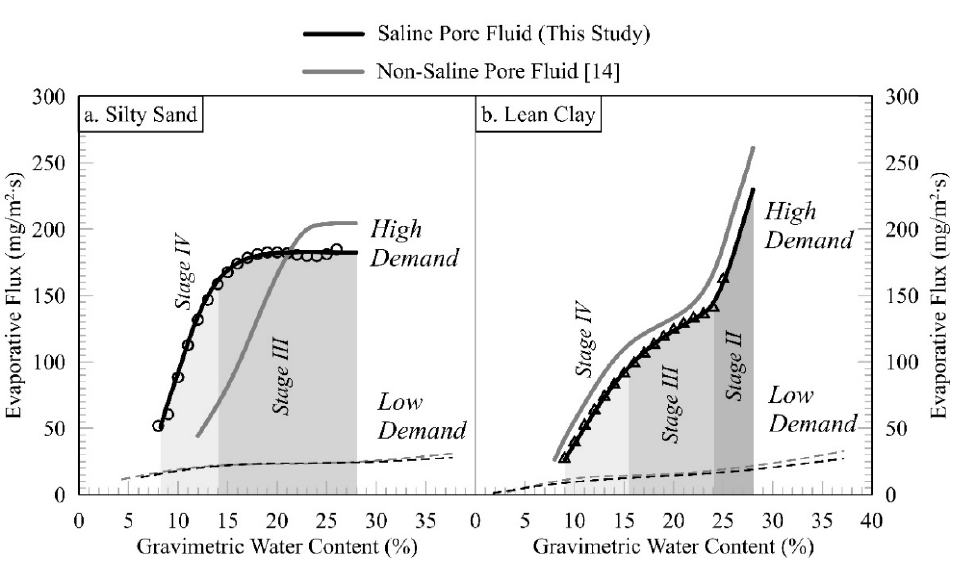
Figure 4. Behavior of lean clay under low atmospheric demand: ( a ) w -based evaporative flux; ( b )  - based evaporative flux; ( c ) S -based evaporative flux; ( d ) w -based water retention curve; ( e )  -based water retention curve; ( f ) S -based water retention curve; ( g ) w -based soil shrinkage curve; ( h )  - based soil shrinkage curve; and ( i ) S -based soil shrinkage curve.